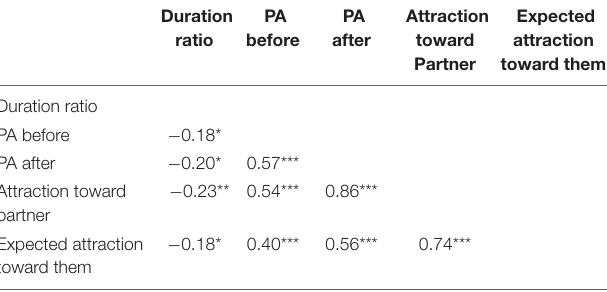
TABLE 2 | Correlations for duration ratio, physical attractiveness before the date, physical attractiveness after the date, participant attraction toward partner and perception of partner attraction toward him, for